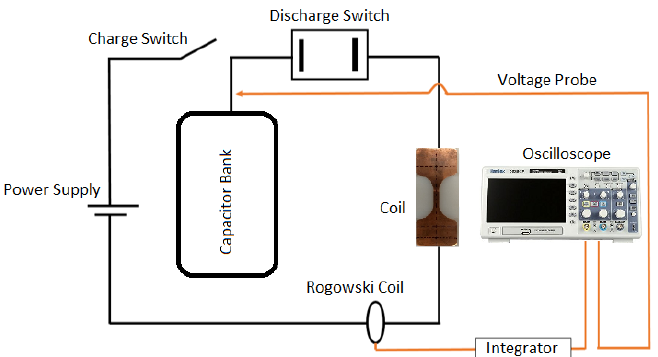
Figure 1. Approximate circuit diagram of the electromagnetic joining (EMJ) process. The Rogowski coil and voltage probe are attached to the capacitor bank to provide the process metrics.